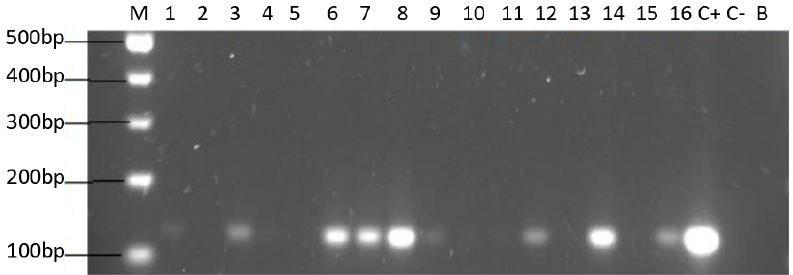
Figure 5. Agarose gel electrophoresis to detect the PCR amplification of the 16S rRNA gene of H. pylori (expected size 100 pb) from the DNA of yeast cells from vaginal discharges of term pregnant women. Lane M: molecular weight markers. Lane C+: DNA extracted from H. pylori ATCC